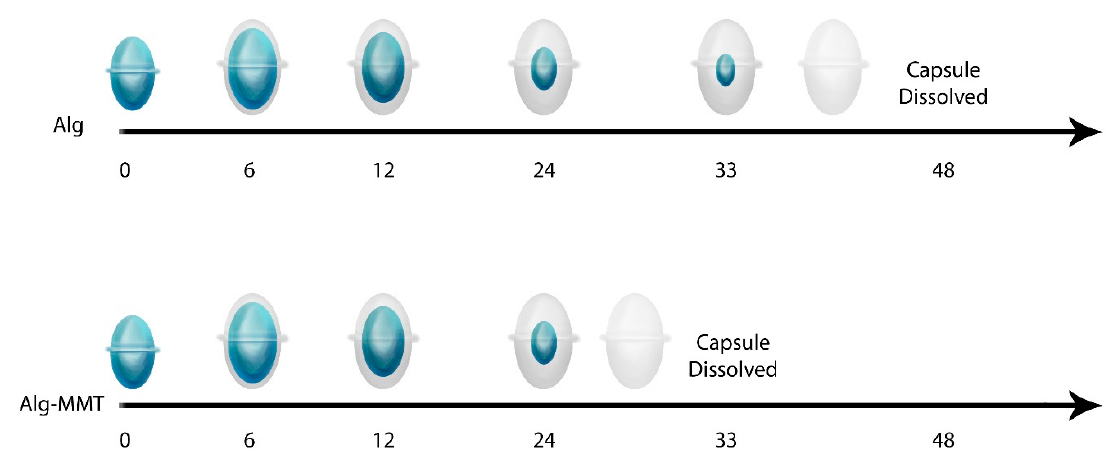
Figure 9. Schematic representing the structure of MMT, including functional groups and possible intercalation between the plates.